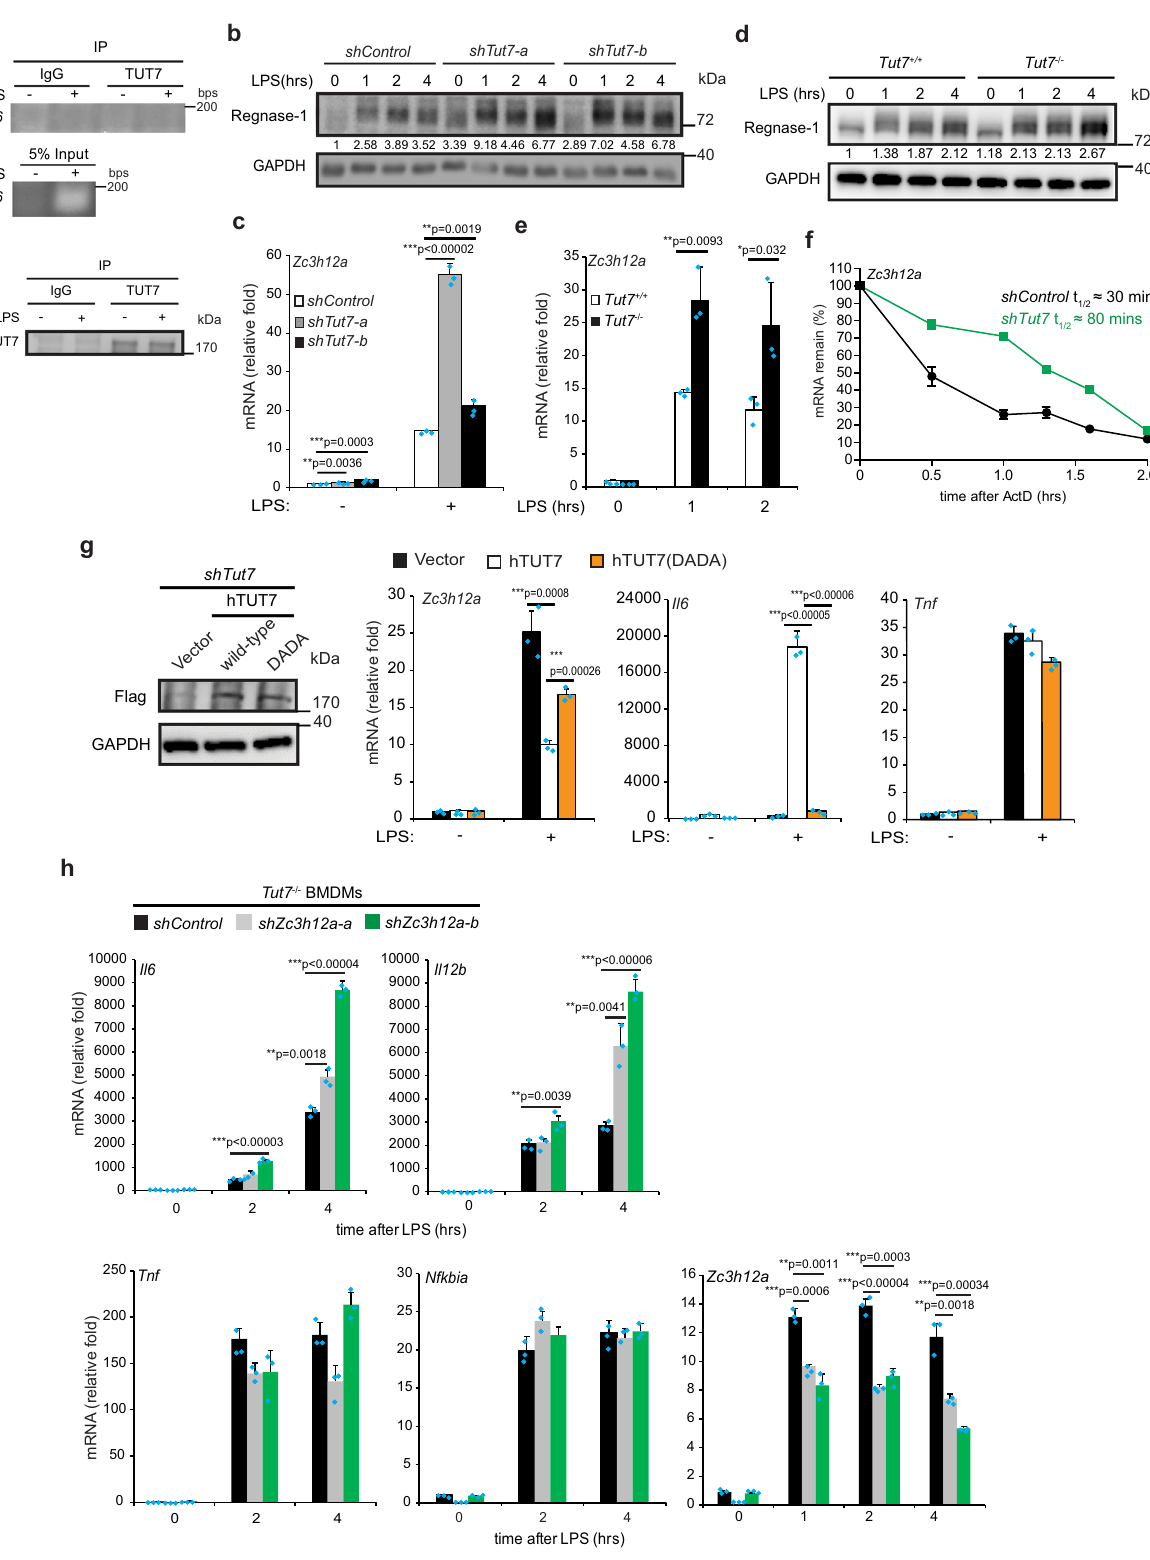
Fig. 8c), suggesting that TUT7 associating with Zc3h12a is dependent on its stem-loop structure rather than the length of its poly(A) tails. Furthermore, the association of TUT7 and Zc3h12a was dependent on its stem-loop structure rather than its sequence NATURE COMMUNICATIONS| (2021) 12:3878